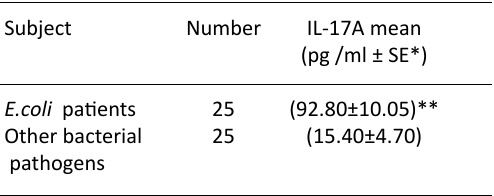
Table 4. IL-17A urine level of E.coli and other pathogens